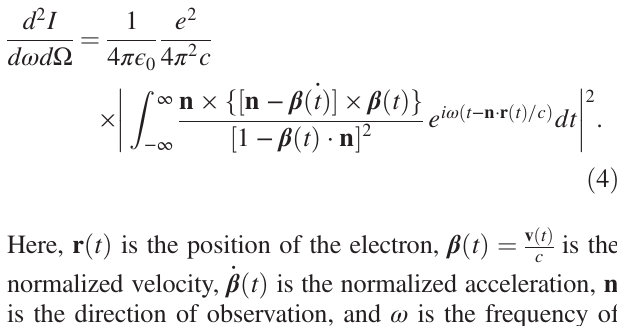
2 . 8 × 10 17 cm − 3 , e ¼